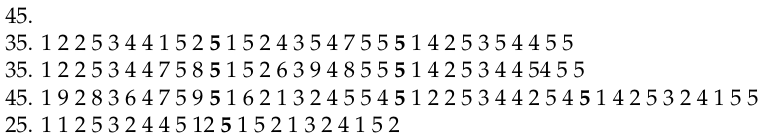
Table 2. Sample problems of Kacem et al. [26,27].